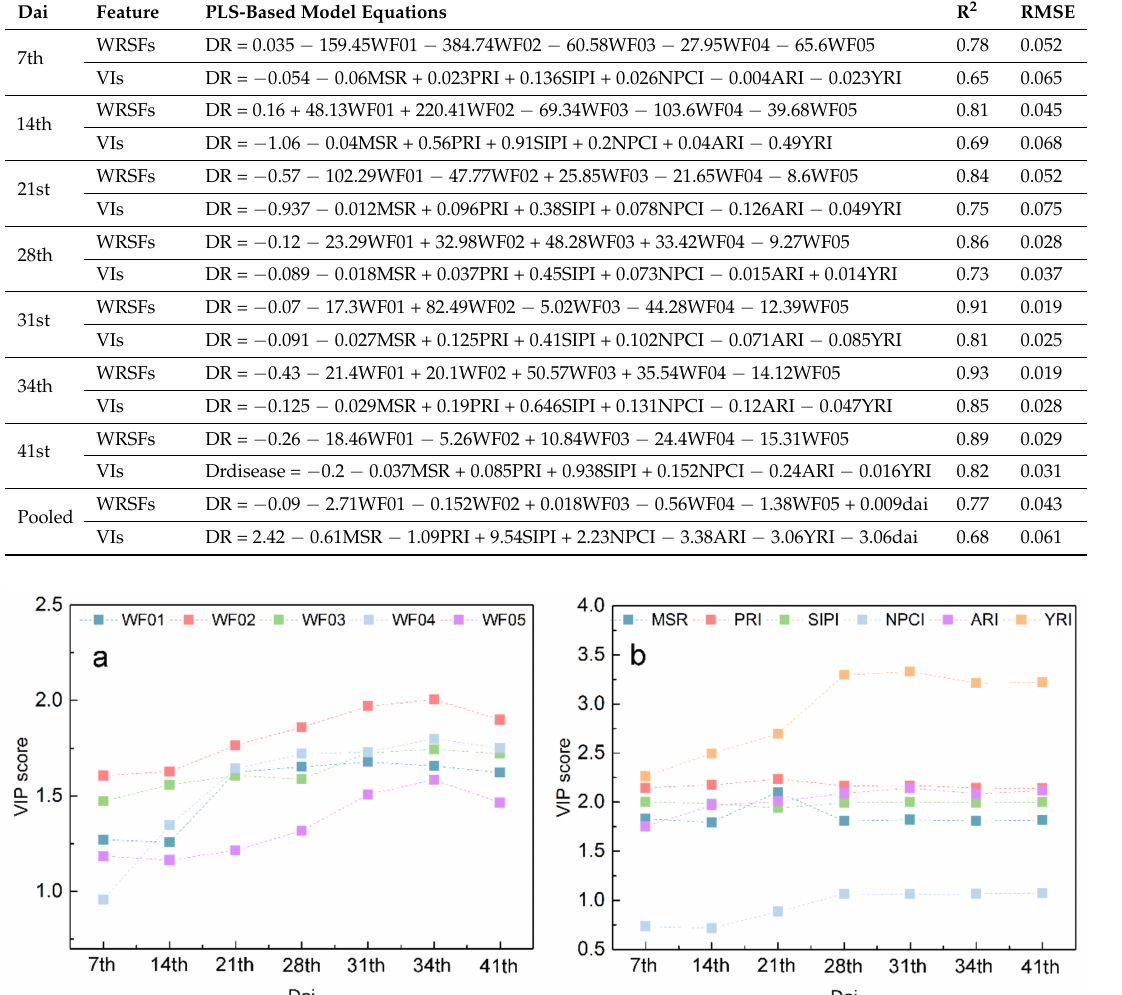
Figure 6. Variable importance in projection (VIP) scores of ( a ) wavelet-based rust spectral feature sets (WRSFs) and ( b ) vegetation indices (VIs) spectral features explaining yellow rust disease ratio (DR) in separate partial least square regression (PLSR) models for each date after inoculation sampled